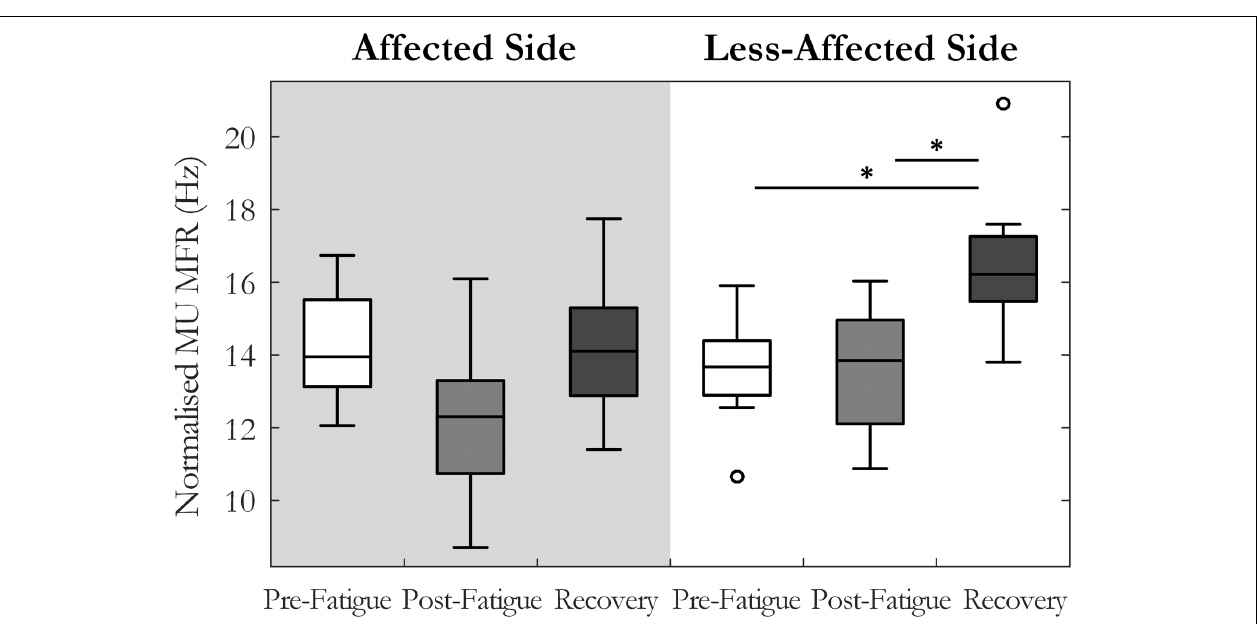
sides (19.3 ± 17%, p = 0.03, g = − 1.1), with higher MU firing rates observed on less-affected side following the recovery